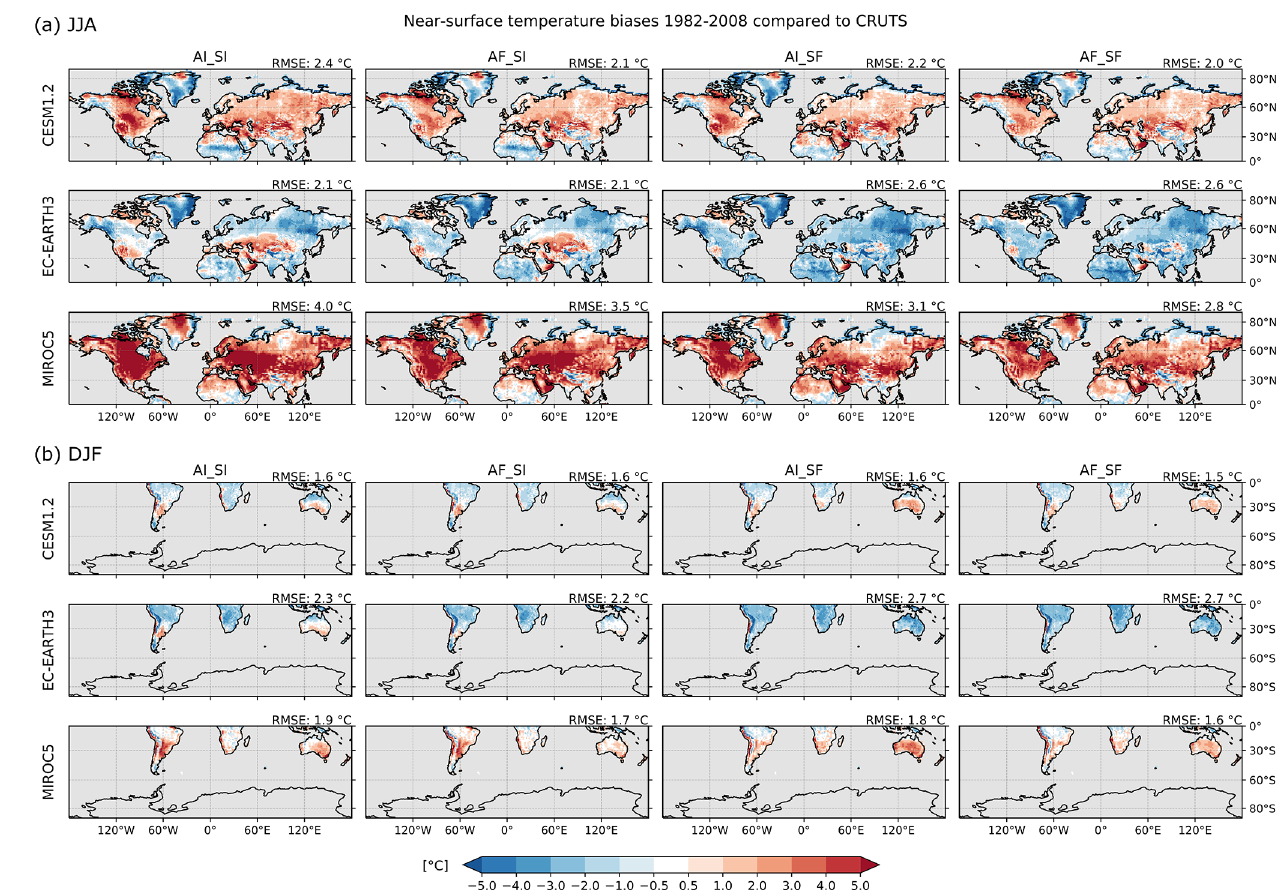
Figure 4. Bias in near-surface temperature (2m) with respect to CRUTS. Shown is the seasonal average over (a) June–July–August (JJA) for the Northern Hemisphere and (b) December–January–February (DJF) for the Southern Hemisphere. Ocean grid points and Antarctica are masked out in grey. The root mean square error (RMSE) averaged over all land grid points of the respective hemisphere is given in the upper right corner of each experiment and